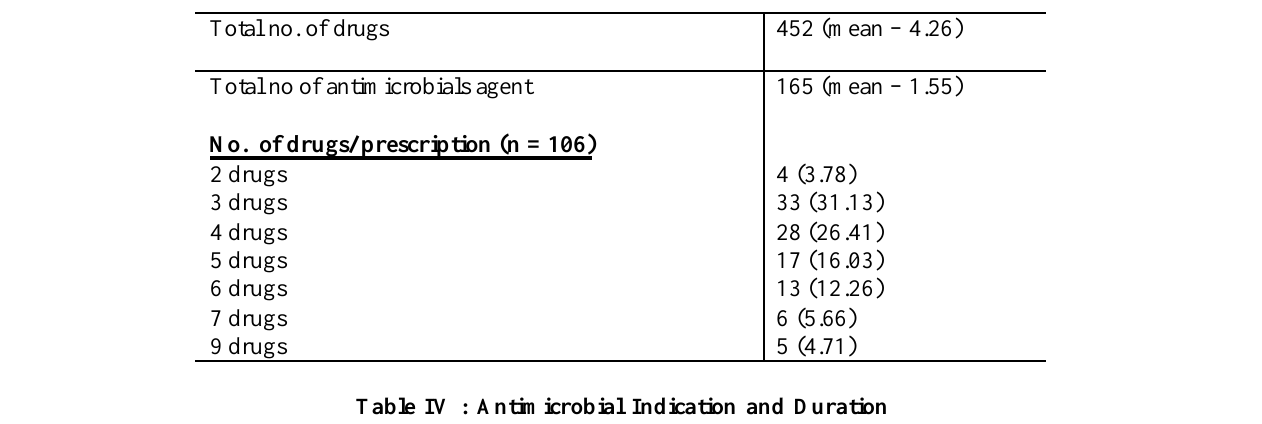
Table III : Antimicrobials (AMAs) data (n=106)